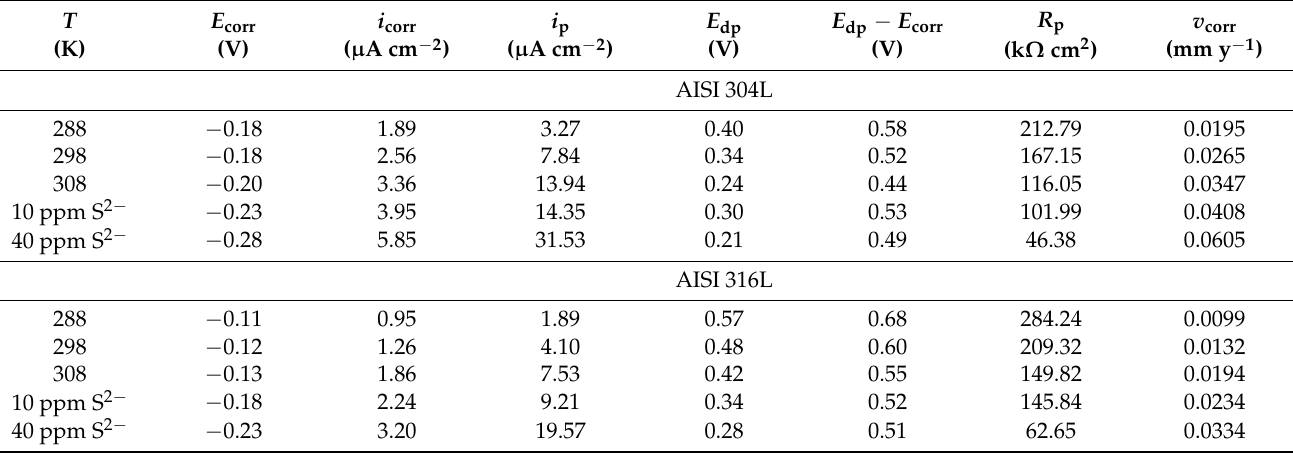
Table 5. Corrosion parameters for the stainless steels AISI 304L and AISI 316L in seawater at different temperatures and different Na 2 S concentrations (at 298